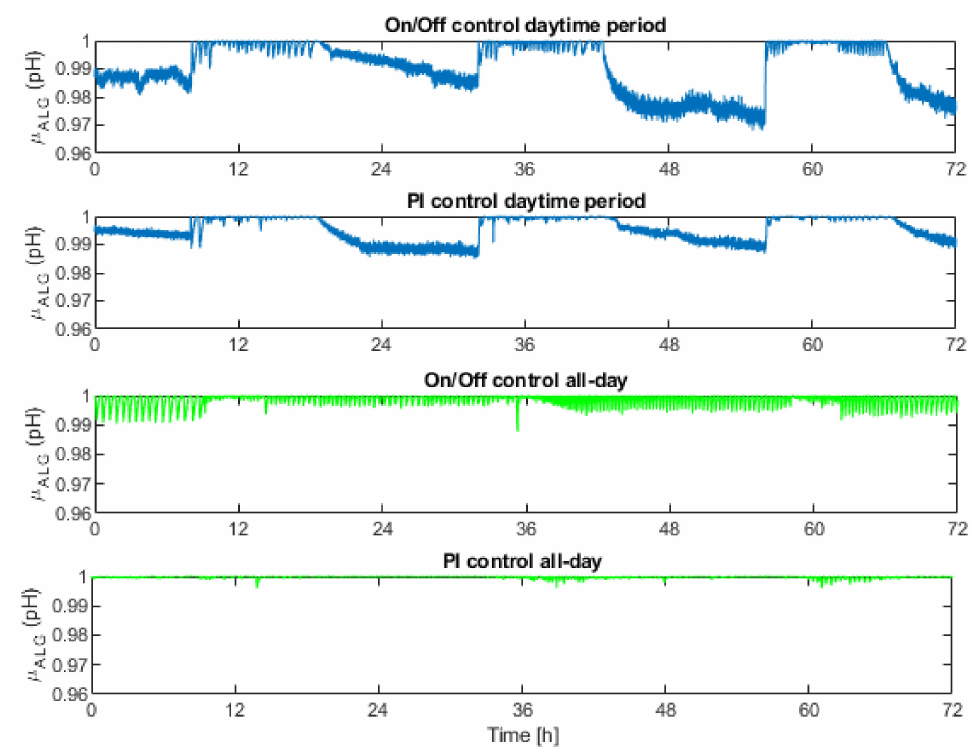
Figure 9. Results of the growth rate influenced by the pH in thin-layer reactors. First graph represents the evolution of this term with On/Off controller operated during daytime period. Second graph represents the evolution of this term with PI controller operated during daytime period. Third graph represents the evolution of this term with On/Off controller operated all-day. Fourth graph represents the evolution of this term with PI controller operated